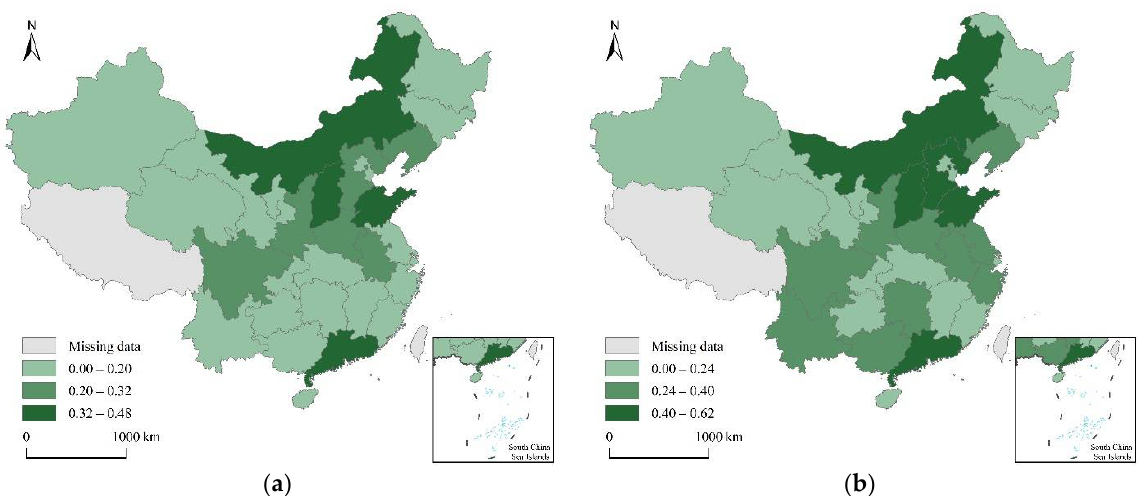
Figure 6. The distribution of traditional transportation development in 2013 and 2020. ( a ) 2013; ( b ) 2020.